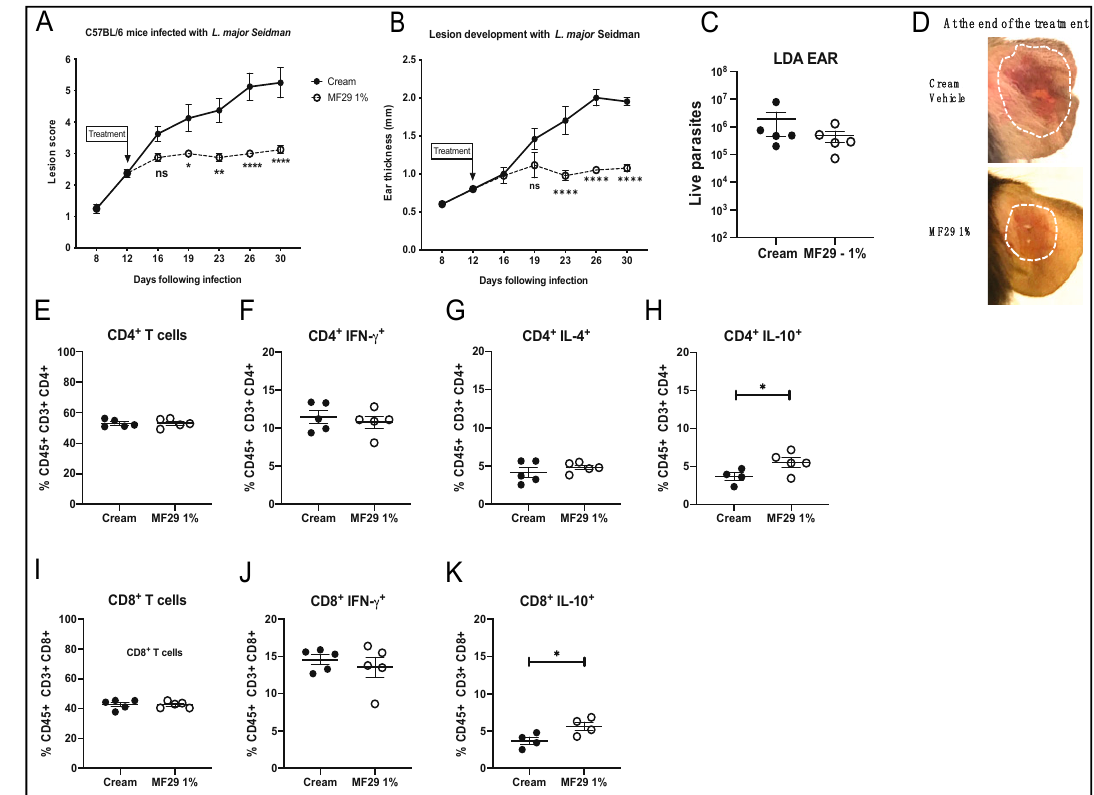
Figure 5. Topical treatment with MF29 1% significantly decreases cutaneous pathology following infection with L. major Seidman (Sd). C57BL/6 mice were infected i.d. with metacyclic L. major Sd promastigotes. Topical treatment with vehicle cream (cream) or MF29 1% cream was initiated once daily as indicated. The lesion development is shown as ( A ) lesion score and ( B ) ear thickness. Data are represented as mean ± SEM, Two-Way ANOVA (Bonferroni’s post-hoc test) * p < 0.05, ** p < 0.002, **** p < 0.0001, ns = not significant. ( C ) Parasite load in the infected ears was determined by LDA. ( D ) Representative picture of one ear, either treated with vehicle, or with MF29 1% cream. ( E ) The